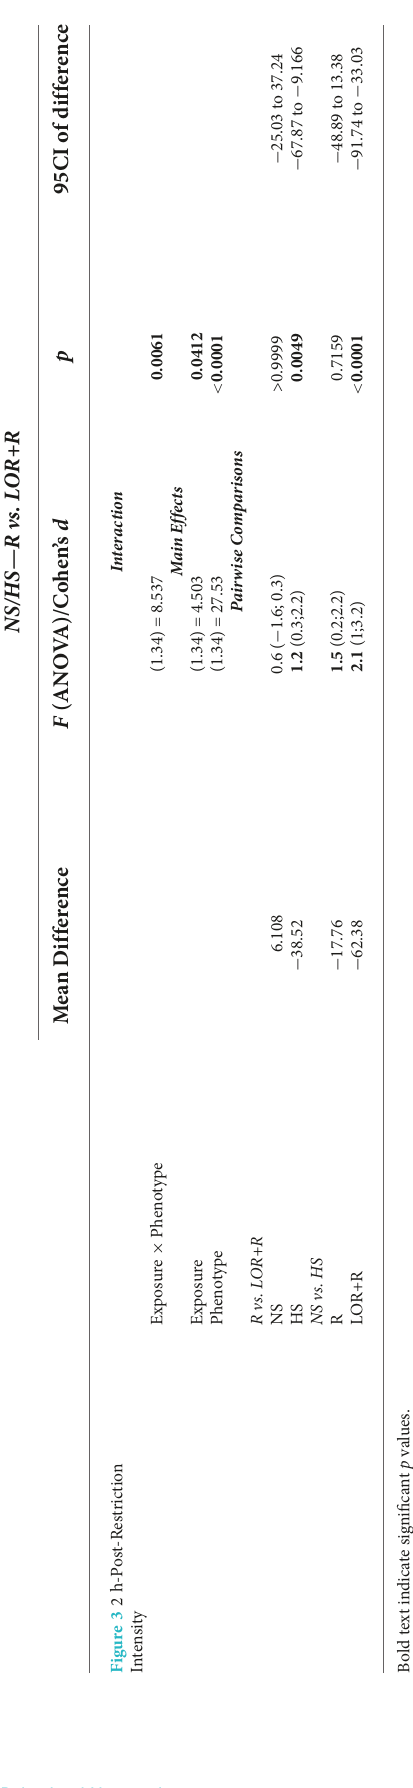
Here, the total time spent engaging in HS behavior by both NS ( Figure 5A ; Table 4 ) and HS animals ( Figure 5B ; Table 4 ) of the different exposure groups during the remainder of the dark cycle, i.e., all bouts excluding the time during which behavioral restriction was applied, was compared. For this, data from all three nights were again pooled. For NS animals, no significant exposure-time interaction was shown. Again, time impacted the result in a significant